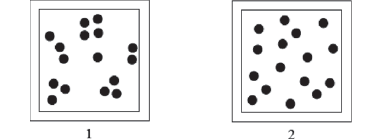
FIG. 12. Third page of the kinetic molecular theory of gases concept